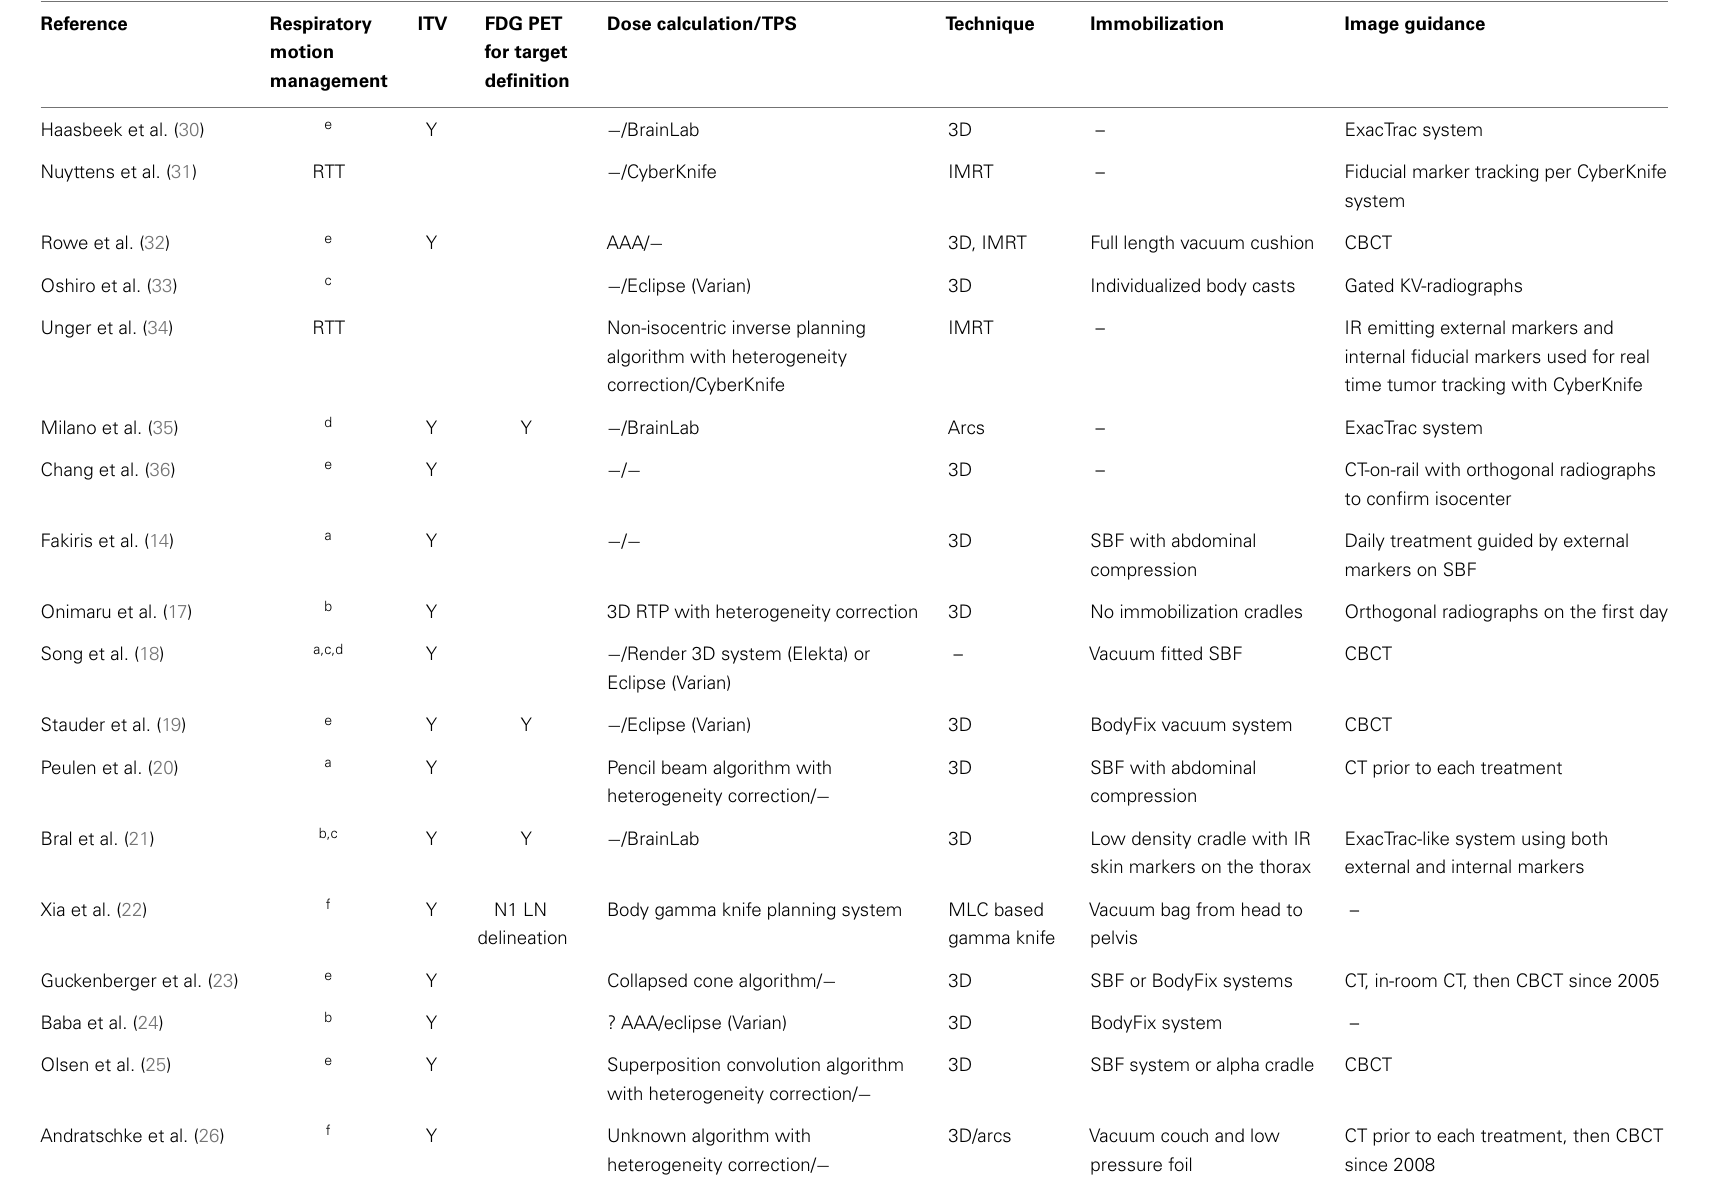
Table 5 |Treatment planning, immobilization, and image guidance in SABR for central lung tumors